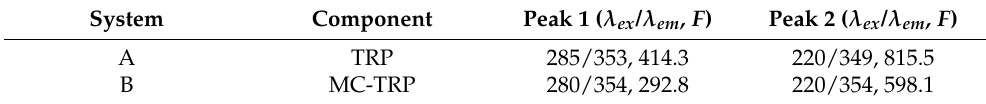
Table 4. Three-dimensional fluorescence spectra characteristic of TRP and